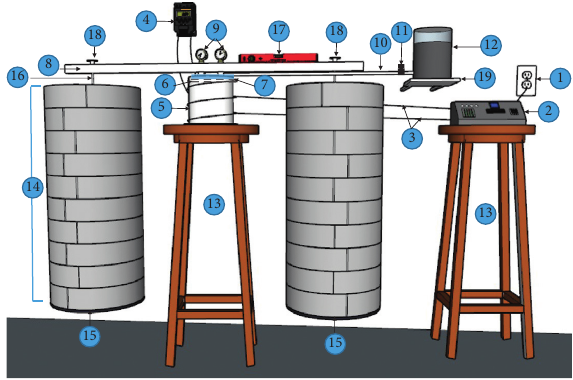
Figure 2: Schematic diagram of the laboratory experiments